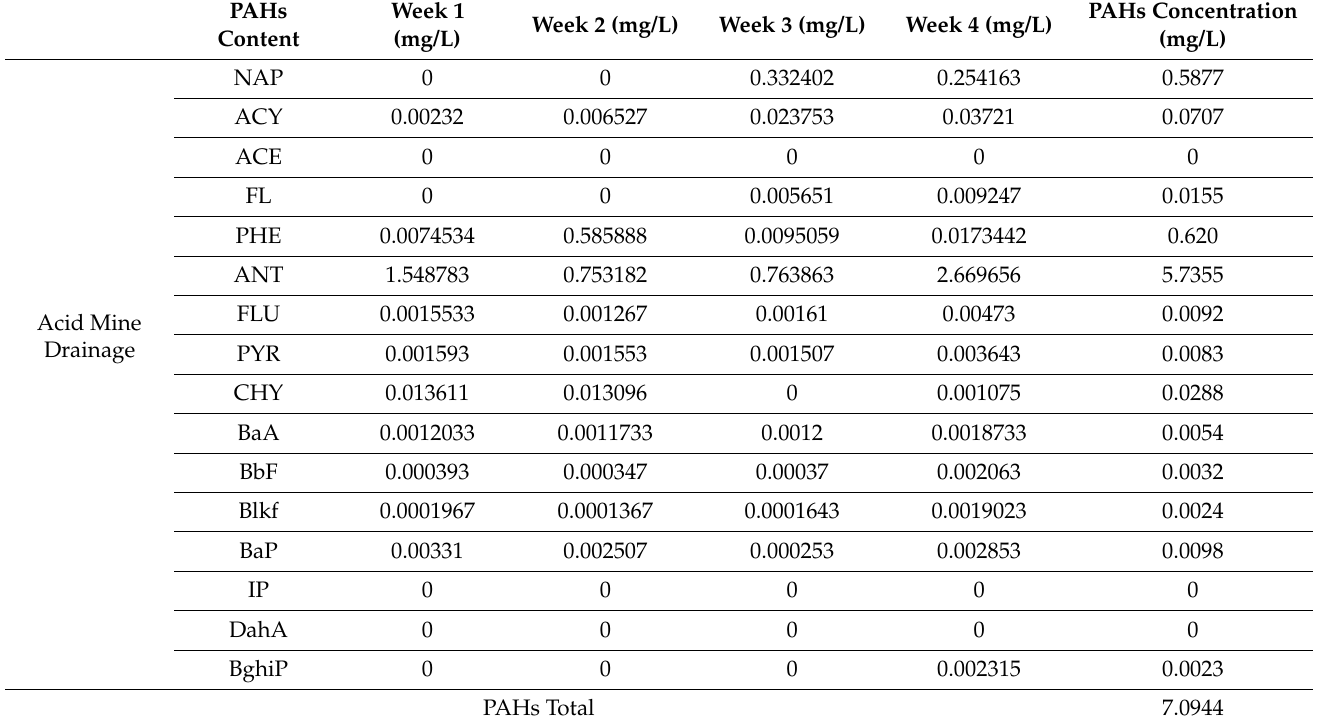
Table 5. The recovery of PAHs in an acidic mine drainage @ 25 ◦ C.